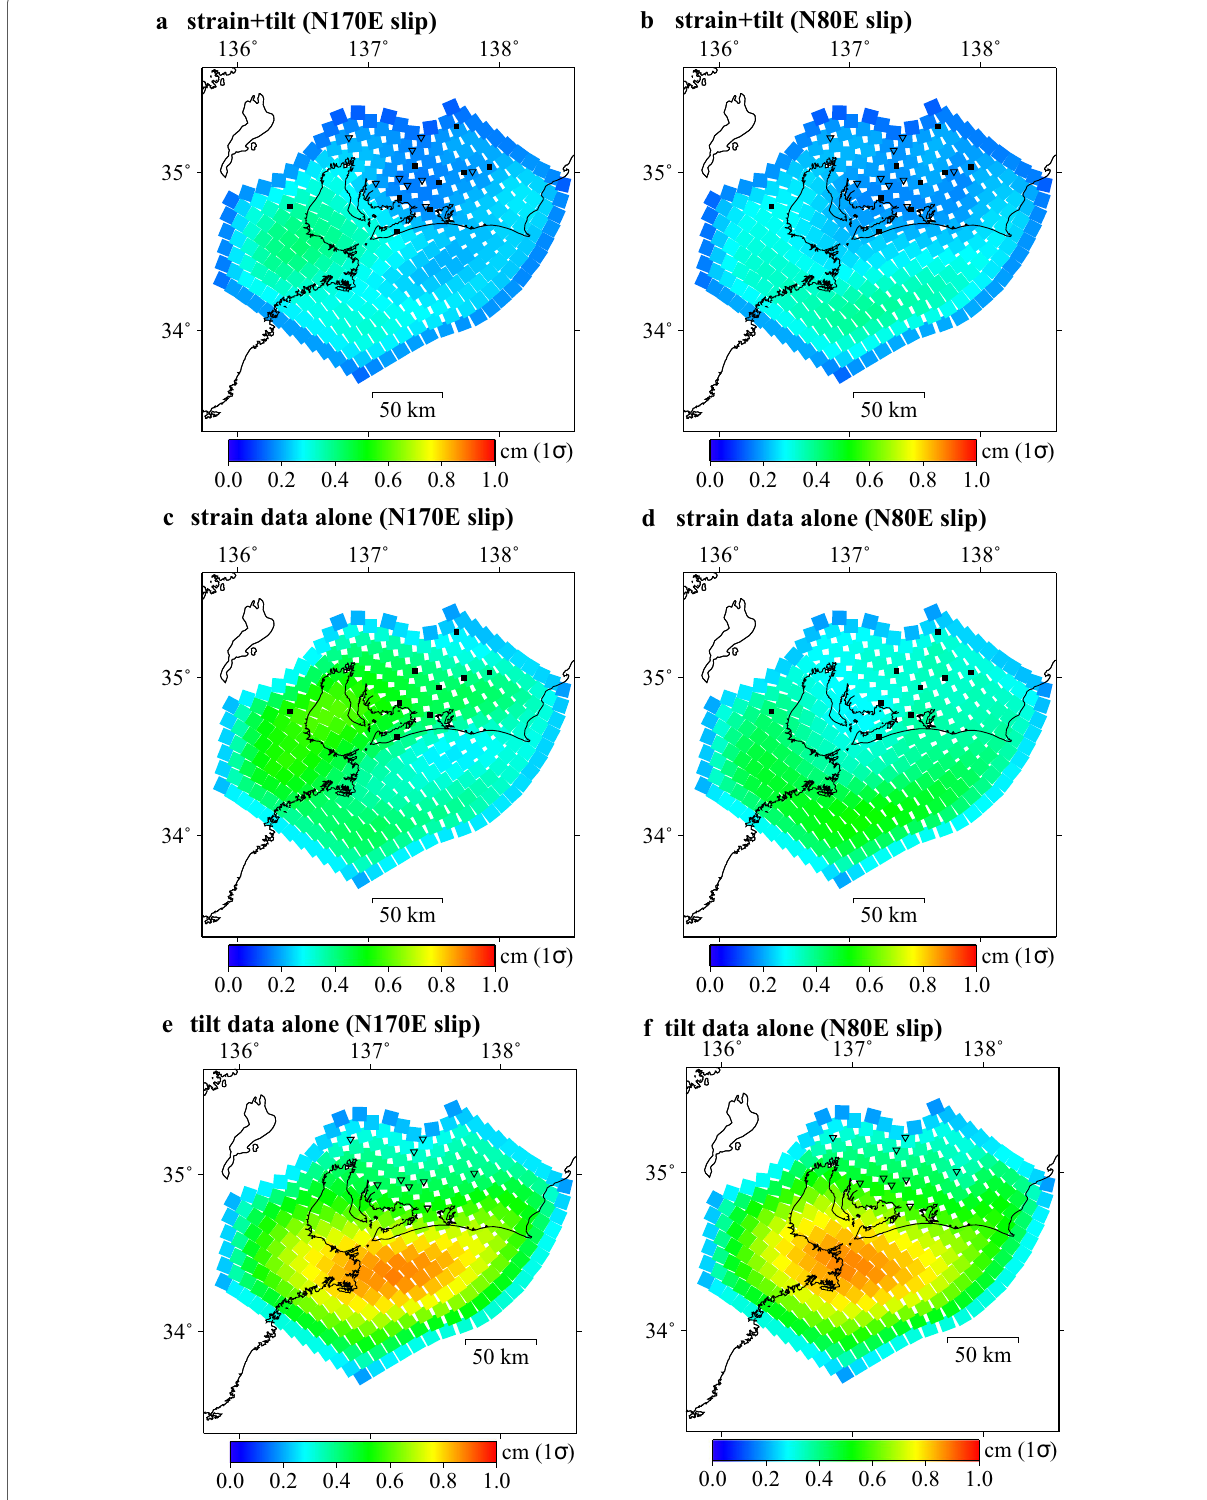
Fig. 8 Distribution of the standard deviation (1 σ ) of the estimated slip (Fig. 7) in the N170E direction (left panel) and N80E direction (right panel) at each subfault. Map region corresponds to Area A in Fig. 1. a , b Standard deviation of the estimated slip based on strain and tilt data. c , d Standard deviation of the estimated slip based on strain data alone. e , f Standard deviation of the estimated slip based on tilt data